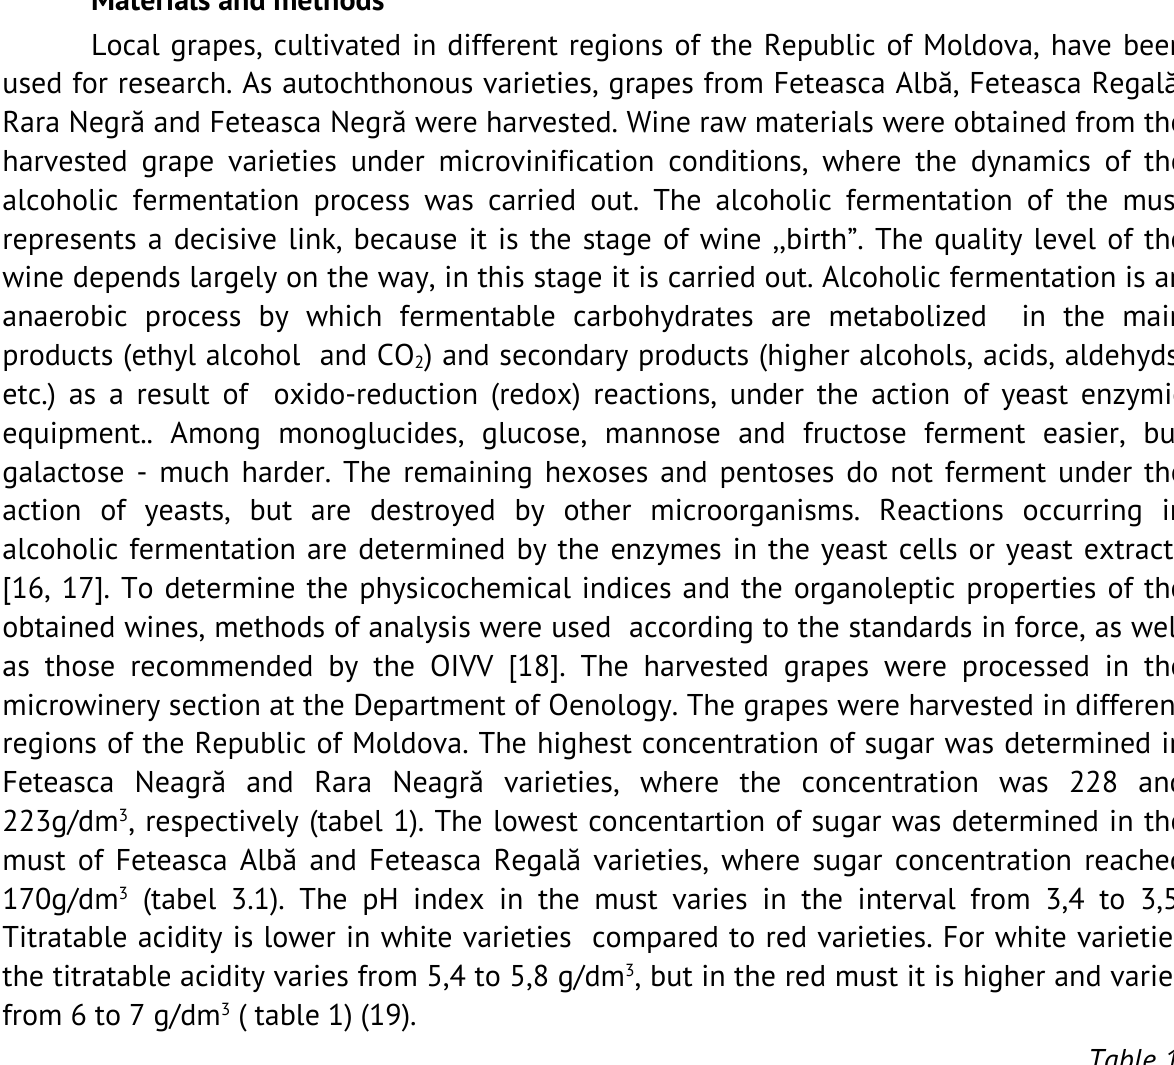
Physico-chemical indices of must from white and red grapes Grape